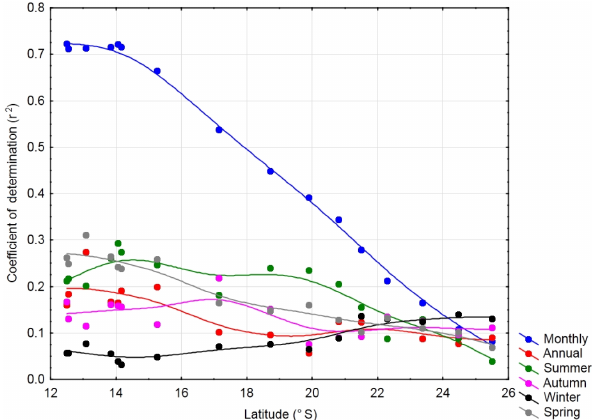
Figure 7. Correlations between rainfall and the climate index of maximum correlation at each site along the NATT (Table 1) for the period 1900 to 2010. Sites are plotted as their latitude along the transect. A distance weighted least squares fit has been included to enhance the visualisation of the trends along the NATT. The climate indices used for this graph vary depending on site and time period. Indices used for each point on the graph can be found in the “1” columns (highest correlation columns) of Table 4.